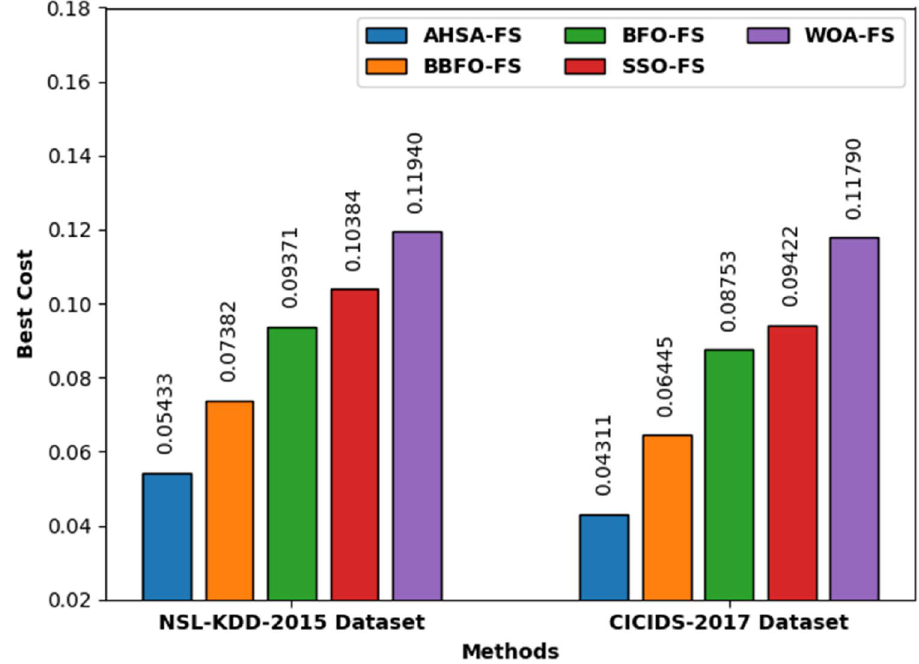
Figure 4. Comparative best cost analysis of the AHSA-FS technique.